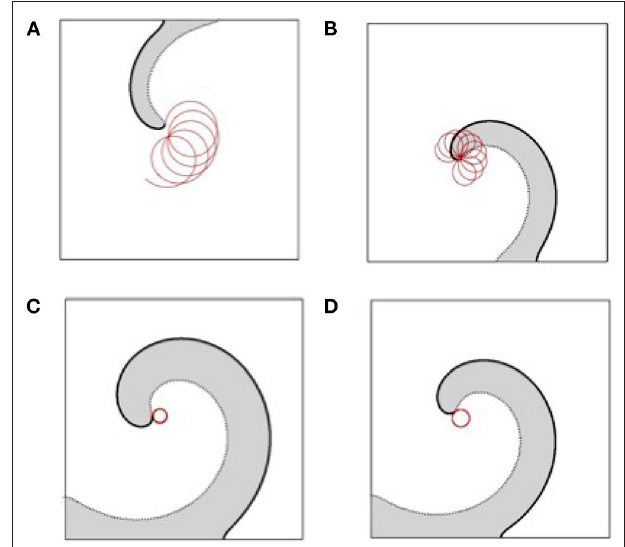
FIGURE 6 | Four examples of the trajectories of the spiral wave tip observed within the gray parameter region shown in Figure 5 with b = 0.002 and (A) a = 0.028, (B) a = 0.04, (C) a = 0.06, (D) a = 0.08.